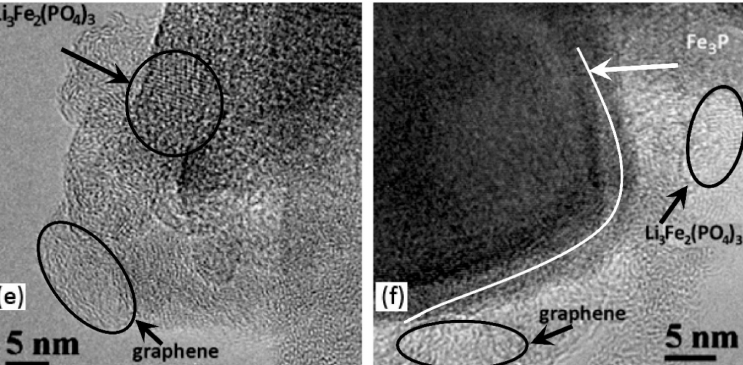
Figure 3. ( a – d )—TEM images of the developed N1 powder of 3 crystallites ( a ); ( b ) is an enlarged part of ( a ). Areas of the ferric-graphite-graphene composite coating layer are marked ( b ); FT snapshot obtained from this TEM image ( c ), a maximum close to the interplanar spacing of 0.428 nm ( d ). ( e , f )—TEM images of industrial powders: N4 ( e ) and N3 ( f ) containing the impurity crystallite phase of Fe 3 P. Regions characteristic of multilayer graphene and the most probable Li 3 Fe 2 (PO 4 ) 3 are also marked.